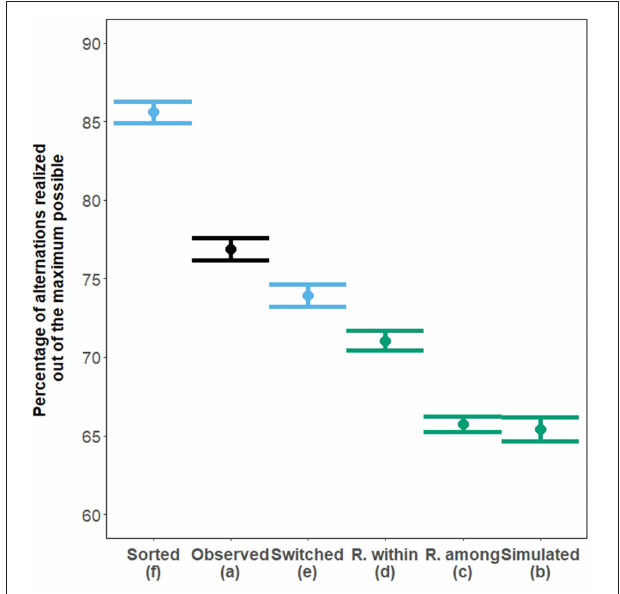
FIGURE 4 | Mean percentage of alternated visits ( ± 95% CI) out of the theoretical maximum (calculated according to both partners’ provisioning rates—see Box 2 ). Random data (randomized or simulated) are in green, and those can be used as a baseline expectation to compare with the observed alternation [(a), black]. The exploration of the process under which shared environmental influences affect partners’ patterns of visits, and increases in the levels of alternation is represented in blue. All plotted pairs of means are significantly different (Tukey contrast post-hoc test, all p < 0.0001) except for between the simulated dataset and the randomization among nest watches ( p =